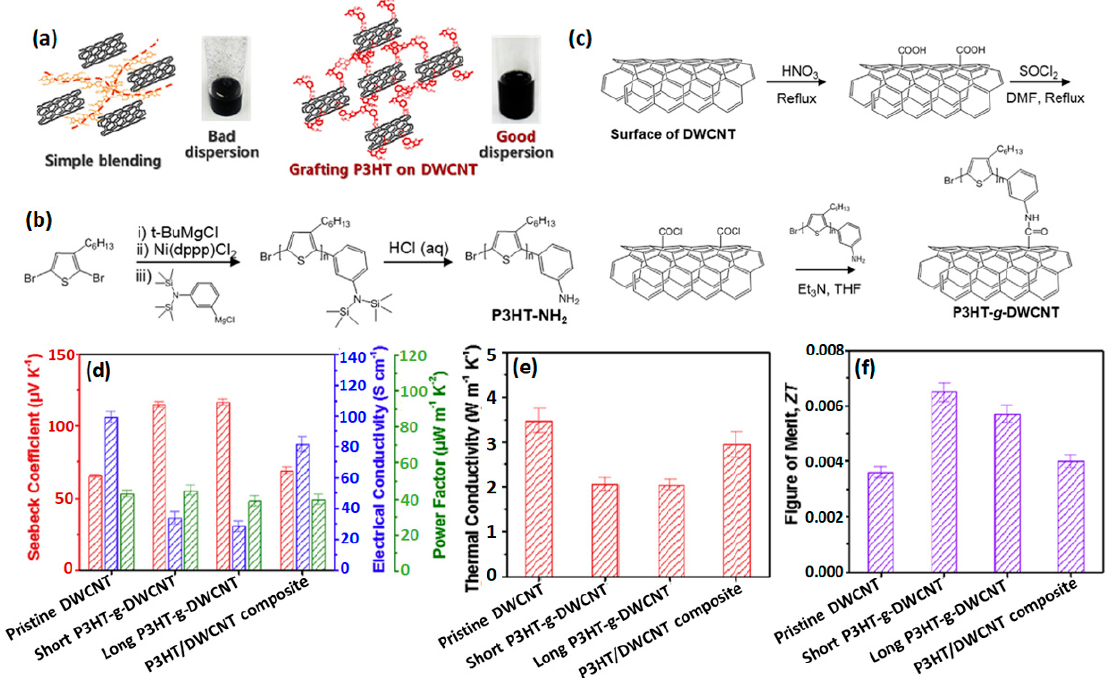
Figure 12. (a) Schematic comparison of preparation of P3HT/DWCNT nanocomposites through Figure 12. ( a ) Schematic comparison of preparation of P3HT/DWCNT nanocomposites through simple blending and covalent grafting. Reaction route for the synthesis of (b) P3HT-NH 2 and (c) simple blending and covalent grafting. Reaction route for the synthesis of ( b ) P3HT-NH 2 and ( c ) P3HT-g-DWCNT. (d) Seebeck coefficient (red column), electrical conductivity (blue column), and P3HT-g-DWCNT. ( d ) Seebeck coefficient (red column), electrical conductivity (blue column), and corresponding power factor (green column); (e) thermal conductivity, and (f) figure of merit of corresponding power factor (green column); ( e ) thermal conductivity, and ( f ) figure of merit of pristine pristine DWCNT, P3HT-g-DWCNT, and physically mixed P3HT/DWCNT nanocomposites. DWCNT, P3HT-g-DWCNT, and physically mixed P3HT/DWCNT nanocomposites. Readapted with Readapted with permission from Elsevier Ltd. [100]. permission from Elsevier Ltd.